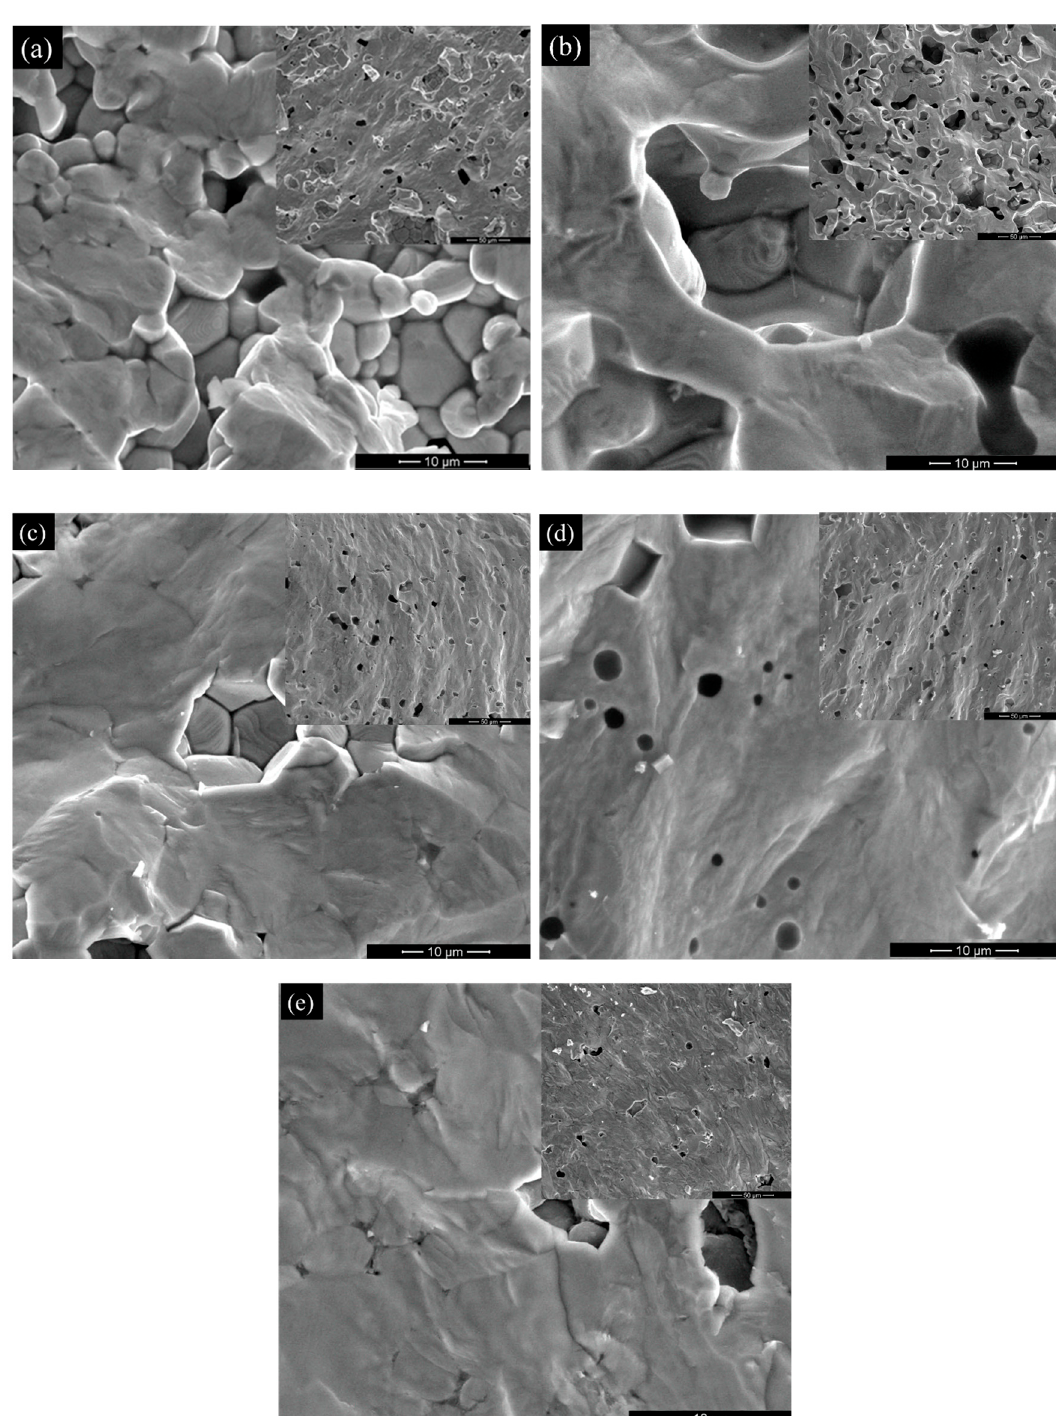
Figure 2. SEM micrographs of ( a ) BCTZ1 (75% r.d.), ( b ) BCTZ2 (76% r.d.), ( c ) BCTZ3 (96% r.d.), ( d ) BCTZ4 (95% r.d.) obtained by conventional sintering, and ( e ) BCTZ5 (97% r.d.) by Spark Plasma Sintering.